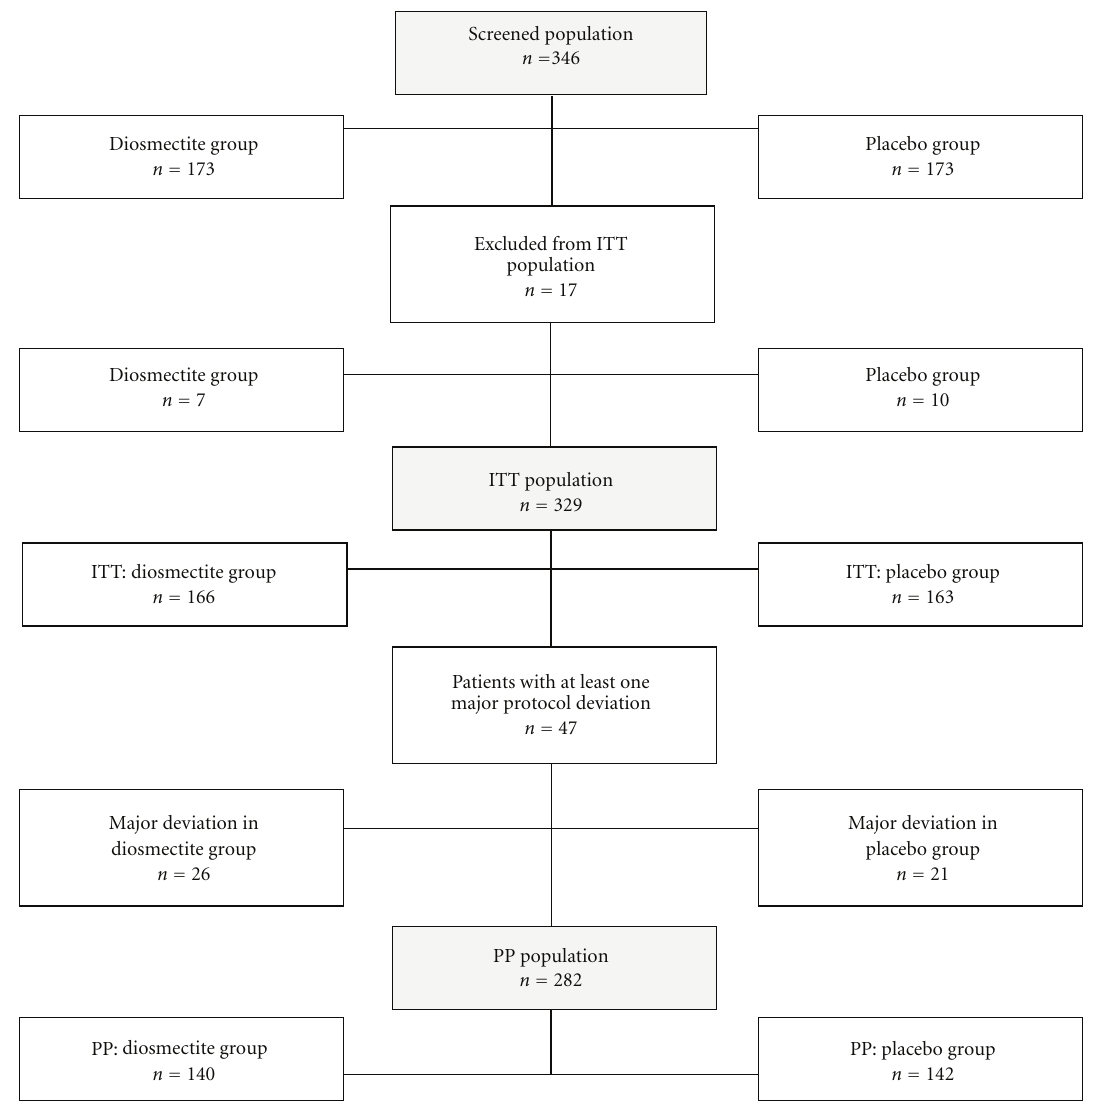
Figure 1: Flow chart of study populations. Diosmectite (6g three times a day) or placebo in the treatment of acute diarrhoea in